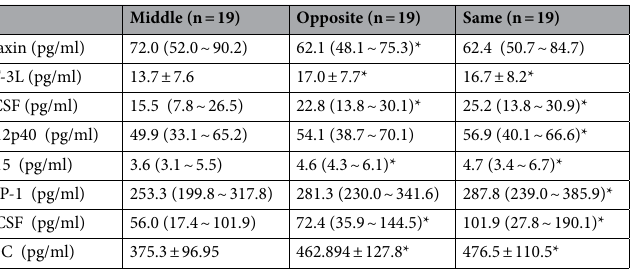
Table 3. Cytokines levels of three subgroups. *P < 0.05 are considered significant when compared with the Middle group, because the comparison between the Opposite and Same groups didn’t show any statistically significant in all the